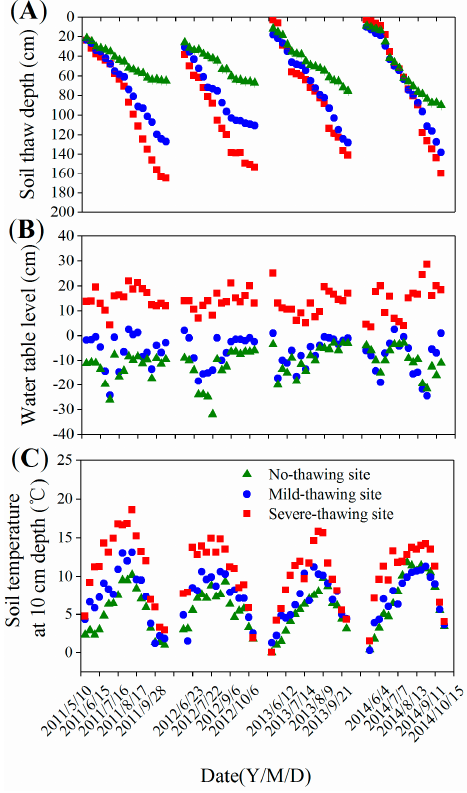
Figure 2. Seasonal variation of soil thaw depth ( A ), water table level ( B ) and soil temperature ( C ) in different sampling sites.